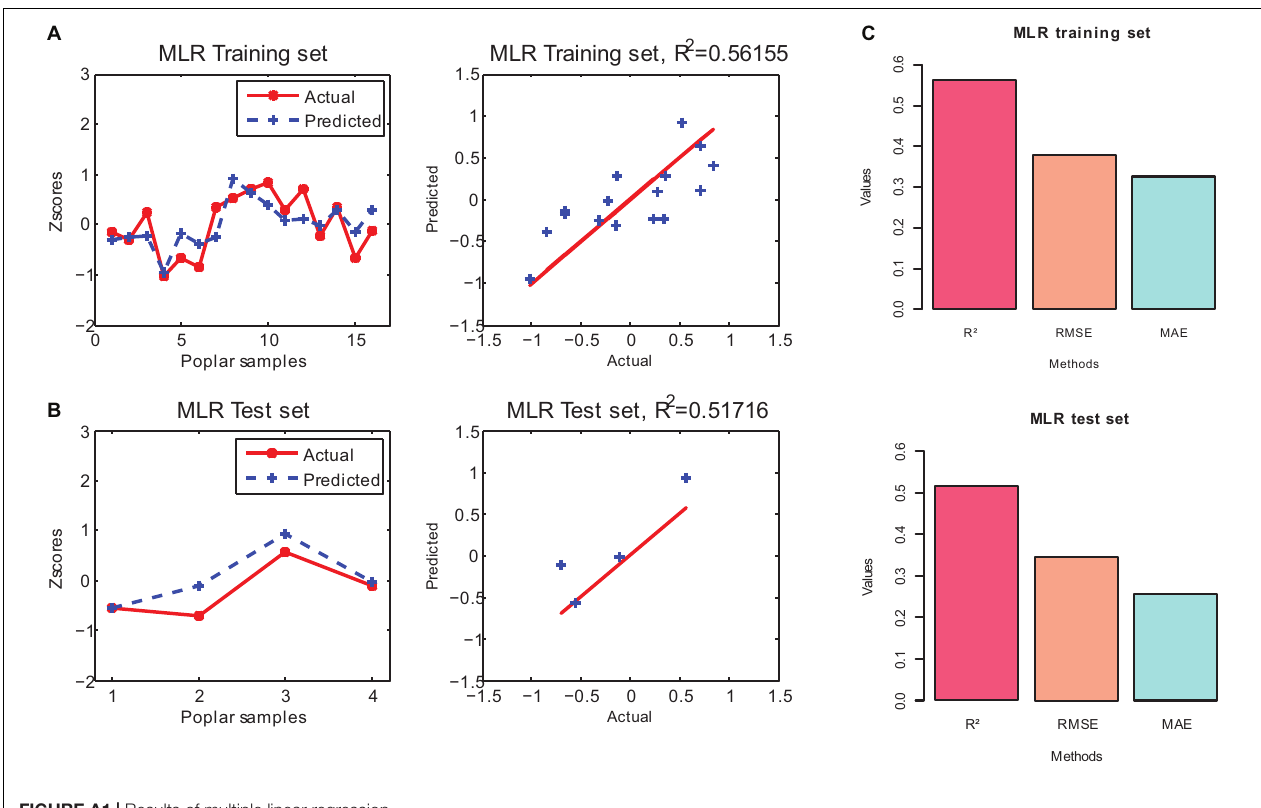
FIGURE A1 | Results of multiple linear